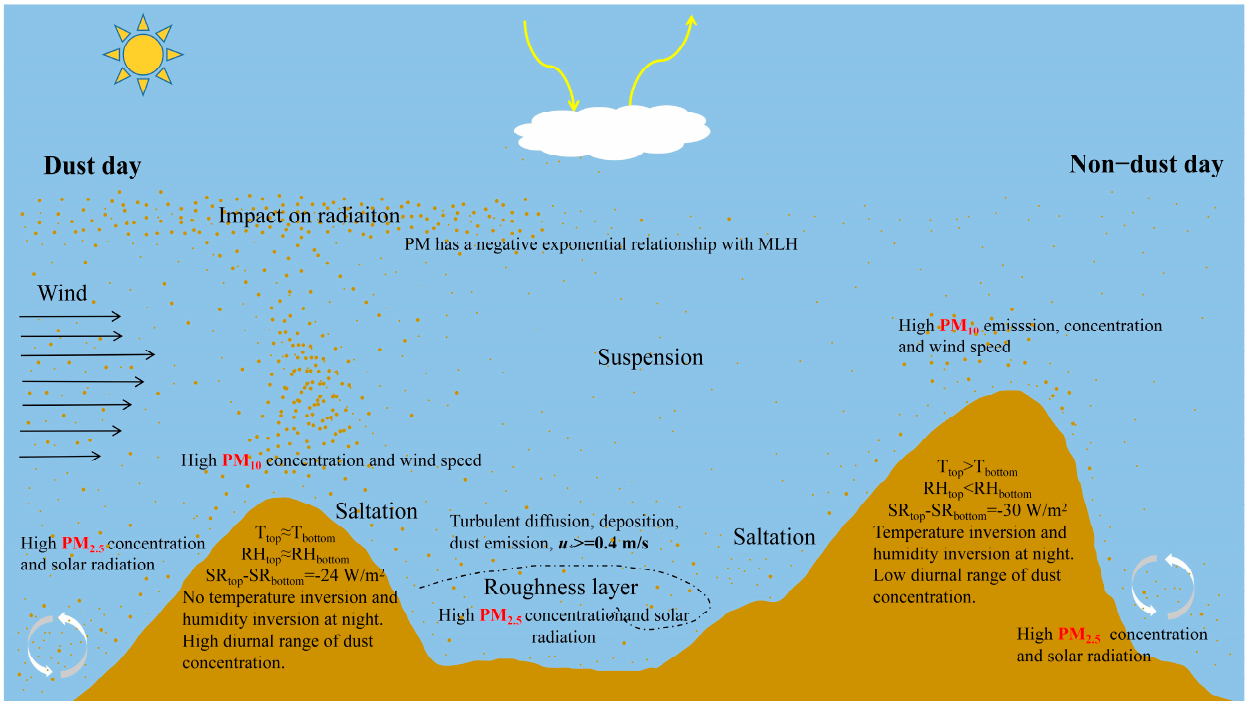
Figure 11. Conceptual scheme of dust emissions and concentrations at the top and bo tt om of dunes in the TD. Solid yellow represents sand dunes. The yellow dots represent dust. T top and T bo tt om represent air temperatures at the top and bo tt om of the dunes. RH top and RH bo tt om represent relative humidity at the top and bo tt om of the dunes. SR top and SR bo tt om represent solar radiation at the top and bo tt om of the dunes. MLH represent mixing layer height. The u * represents the friction velocity.